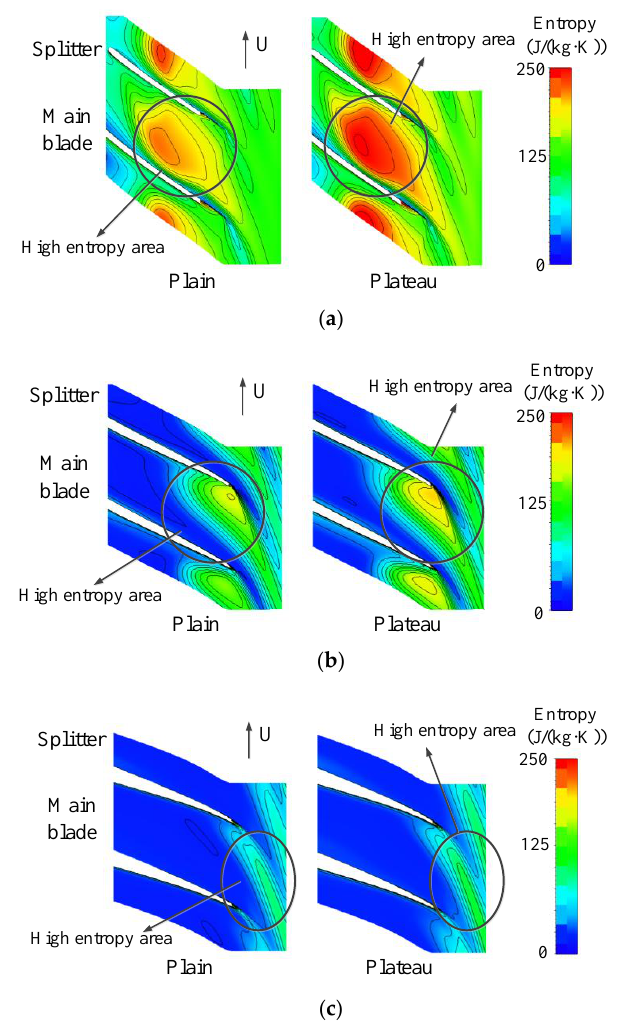
Figure 17. Entropy distribution of the impeller tail: ( a ) 90% blade span ; ( b ) 50% blade span; ( c ) 10% blade span. Energies 2017 , 10 , 2121